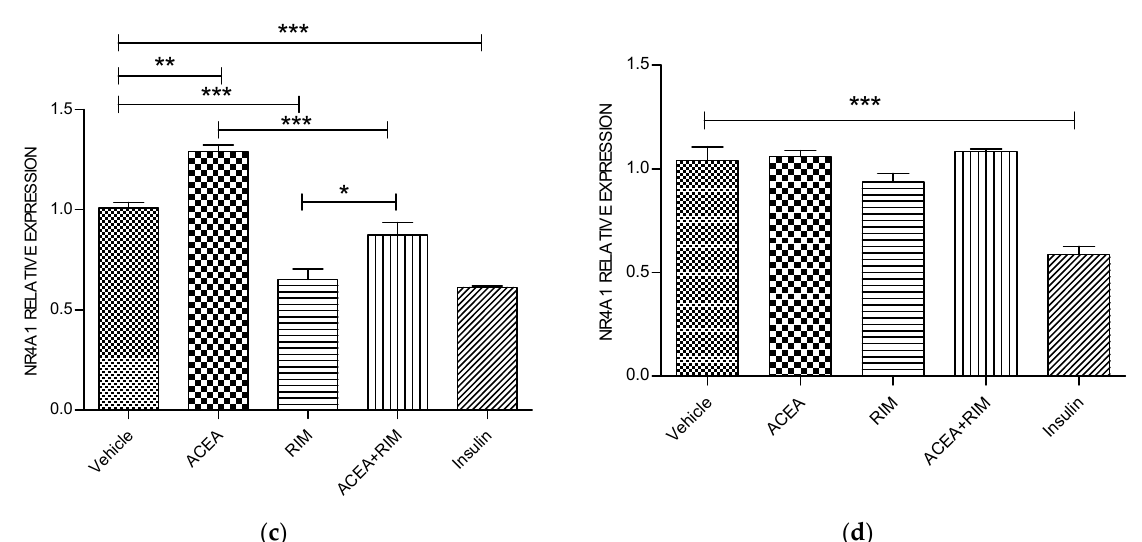
Figure 2. NR4A1 muscle myotubes—ACEA, rimonabant, ACEA and rimonabant, and insulin affect NR4A1 gene expression; myotubes fed with delipidated serum. The stimulation time covered 3 to 24 h, and NR4A1 mRNA levels, relative to TATA-Box, was evaluated by quantitative real-time PCR (qRT-PCR) (100 nM). The following scenarios explain the stimulation process conducted: ( a ) Stimulation was done for 1 h. ( b ) Stimulation was done for 3 h. ( c ) Stimulation was applied for up to 5 h. ( d ) Stimulation was applied for up to 24 h. The data were reported as the mean ± SEM of three separate groups. (n = 3; *denotes p < 0.05, **denotes p < 0.01, and ***denotes p < 0.001). Data were investigated by conducting one-way ANOVA test and Tukey test. NR4A1; nuclear receptor subfamily 4, group A, member 1.